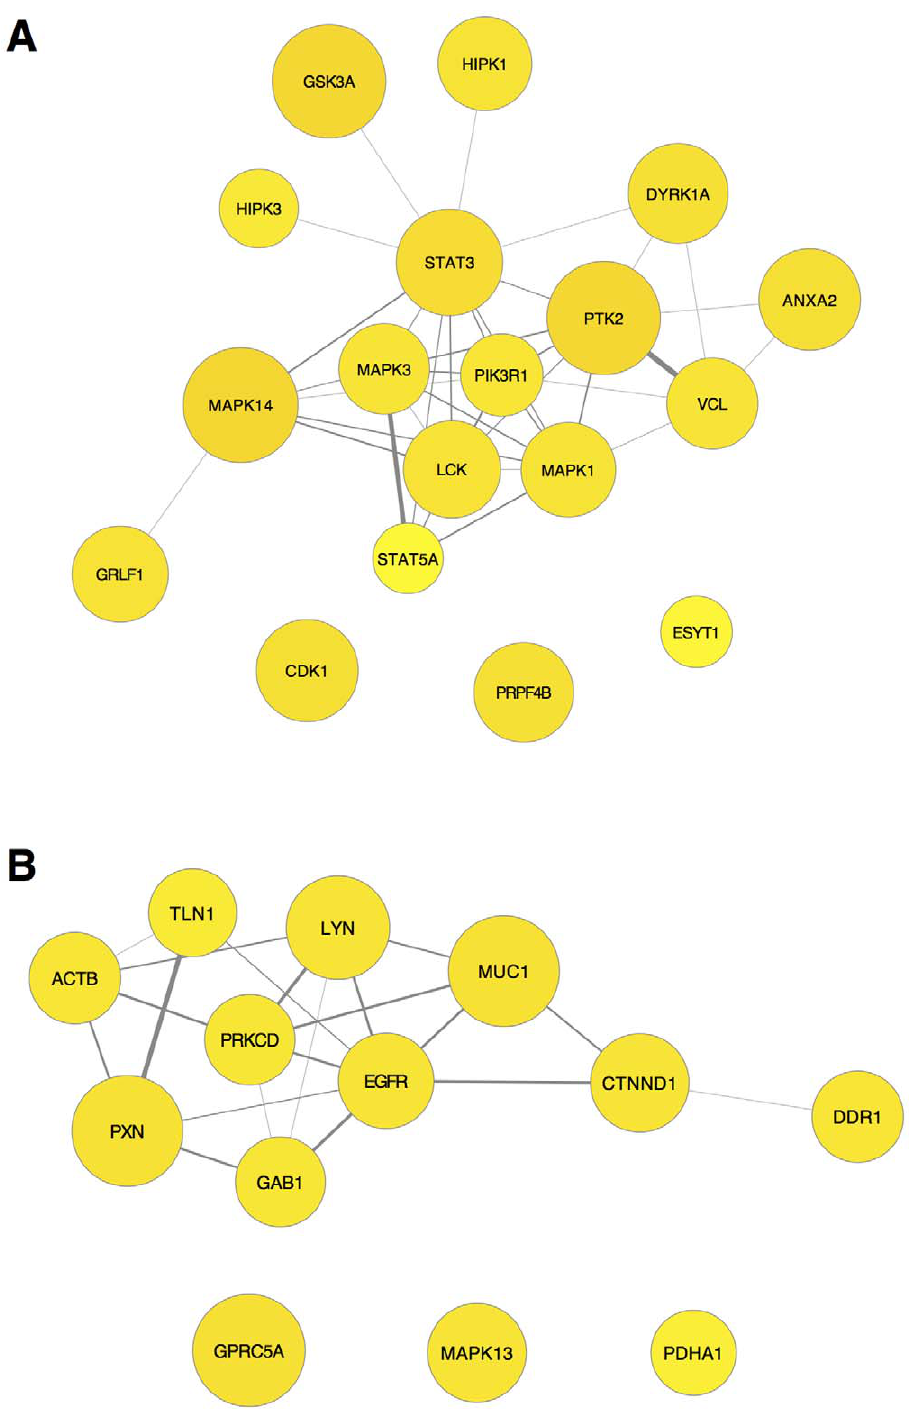
Figure 3. Networks from clusters containing the most highly tyrosine phosphorylated proteins in lung cancer samples. A ) Cluster containing LCK and FAK (PTK2) derived from t-SNE on SED embedding (Figure S4D). B ) Cluster containing EGFR and LYN, derived from first performing t-SNE Spearman and Euclidean embedding separately, then combining these clusters and filtering (Figure S5E). Node size and color (white to yellow) indicates the total number of phosphopeptides detected in all samples. Edges are protein interaction data from String (string.embl.de/), GeneMANIA (genemania.org/), and the kinase-substrate data from PhosphoSitePlus (phosphosite.org). For clarity, since graphs of these clusters including all individual edges were difficult to interpret, edges were merged, and edge weights, which indicate the strength of evidence for interaction, were summed to determine the thickness of the edge line. Protein interaction network data was imported into R for the edge merge and plotted with RCytoscape as described in Materials and Methods. Node position in network graphs was set using an edge-weighted, spring-embedded layout in which highly connected nodes group closer together. The cluster in (A) had 107-fold more edges, 544-fold greater edge weight, and 7.5-fold more GO terms retrieved than the average random cluster. The cluster in (B) had 88-fold more edges, 499-fold greater edge weight, and 10.8-fold more GO terms retrieved than the average random cluster. As an additional measure, the number of edges expected from these